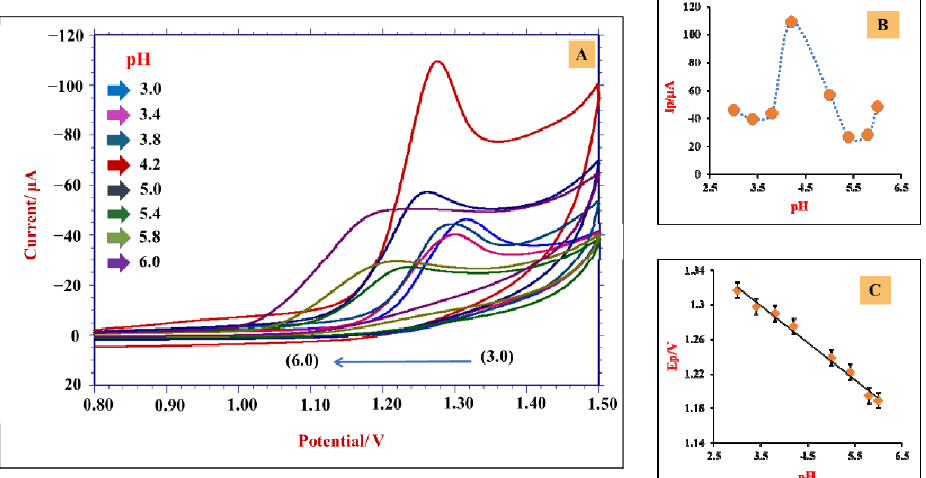
Figure 4. ( A ) Cyclic voltammograms depicting the impact of pH (3.0–6.0) on the oxidation of CIP at SDS ∙ Gr/CPE at a 0.05 Vs − 1 effective scan rate. ( B ) Dependency of a peak current on pH. ( C ) Dependency of a peak potential on pH. The obtained slope value (0.042) was near the Nernstian value (0.059), implying the participation of an equal number of electrons and protons during the reaction